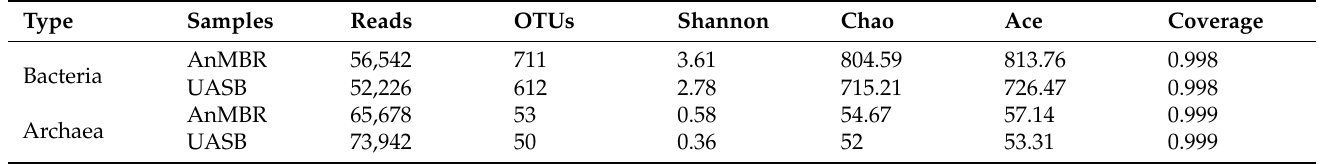
Table 2. Microbial diversity indicators in the sludge from AnMBR and